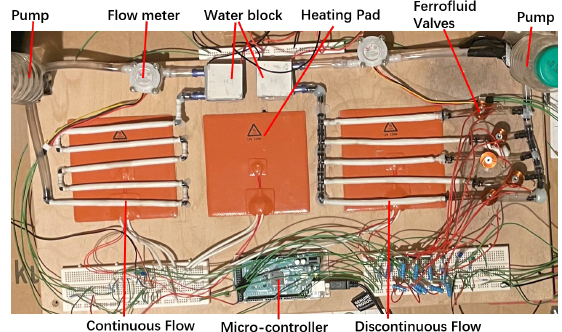
Figure 6. Experimental set-up built on the polywood